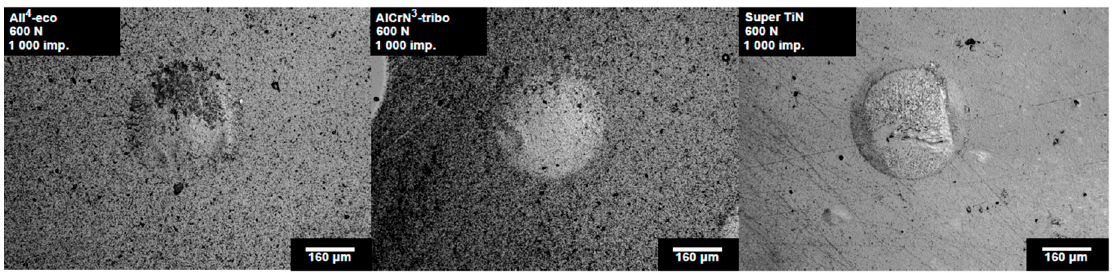
Figure 8. Impact craters of the tested PVD coatings obtained by 1000 impacts and a load of 600 N.